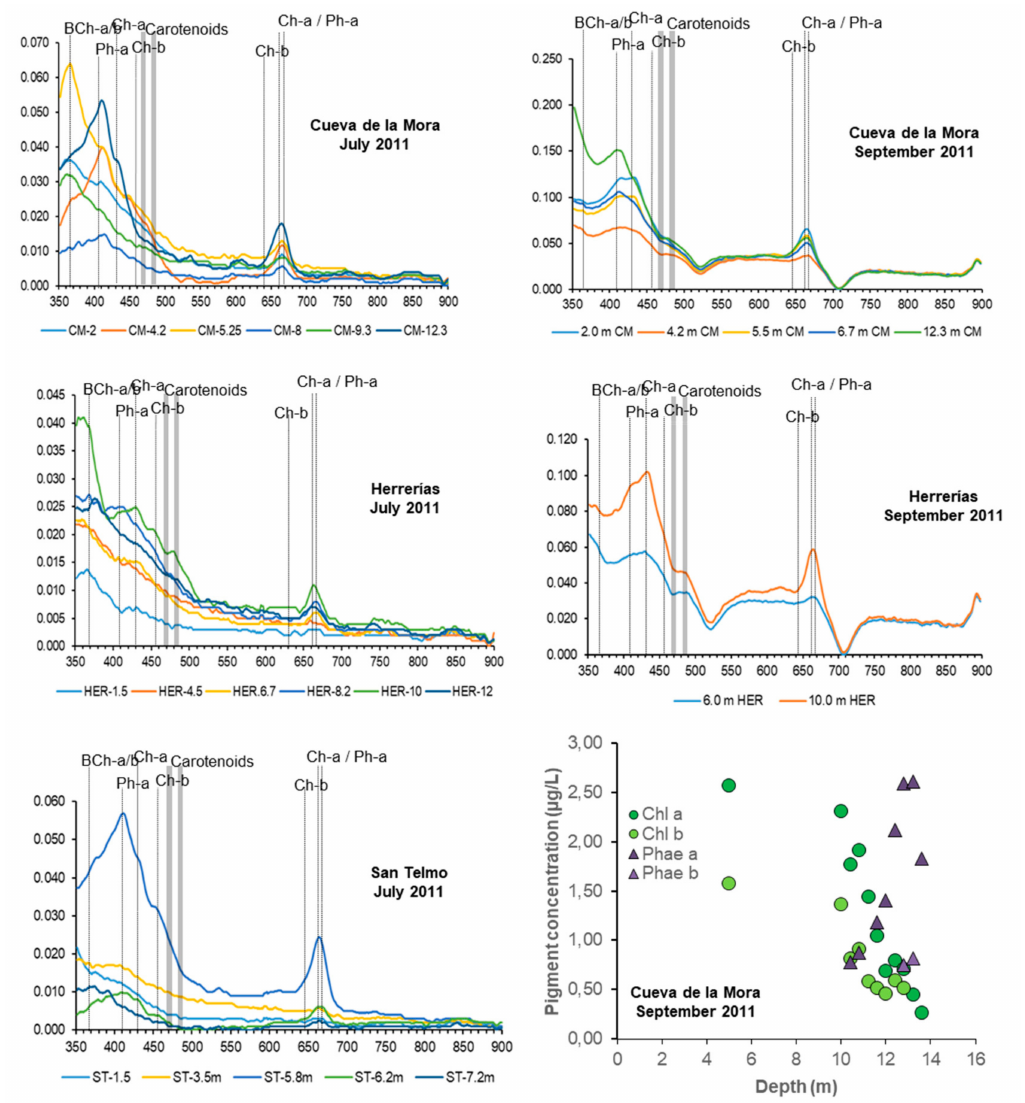
Figure 3. Absorbance spectra of pigments obtained for di ff erent depths (indicated by contour lines of di ff erent color in every plot) in the acidic pit lakes of Cueva de la Mora (CM; top), Herrer í as (HER; center) and San Telmo (ST; left bottom). Analyses were conducted on water samples taken in July and September 2011. The position of di ff erent pigment peaks (Ch-a, chlorophyll-a; Ch-b, chlorophyll-b; BCh-a / b, bacteriochlorophyll- and –b; Ph-a, phaeophytin-a; carotenoids) are indicated in all cases. Spectra were smoothed using a 5 nm running average. Right bottom: Pigment concentration (Chl-a, Chl-b, Phae-a, Phae-b) measured in Cueva de la Mora in September